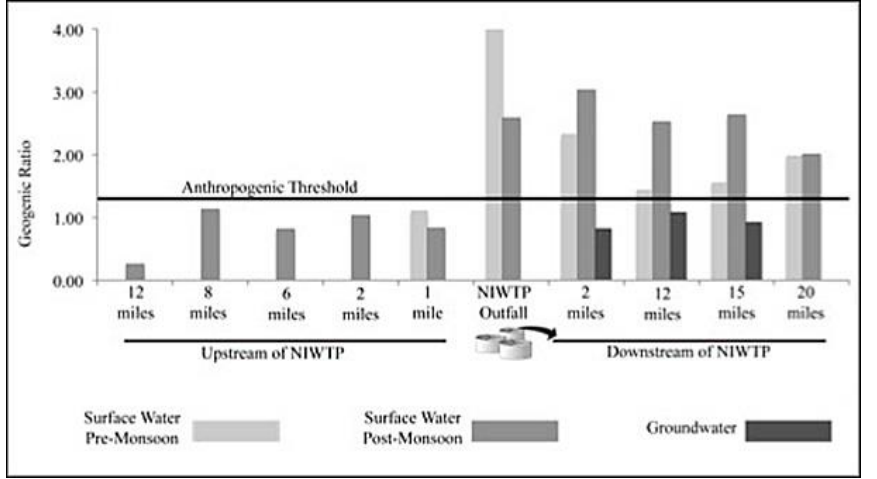
Figure 2. Geogenic Ratio in Upper Santa Cruz River surface and groundwater samples. Values above the anthropogenic threshold of 1.3 indicate the presence of Gd ANTHRO . For dust and soil samples, standardized values of Gd were analyzed in comparison with other REEs. Values for Gd SN were negligible, just above zero (Figure 3).